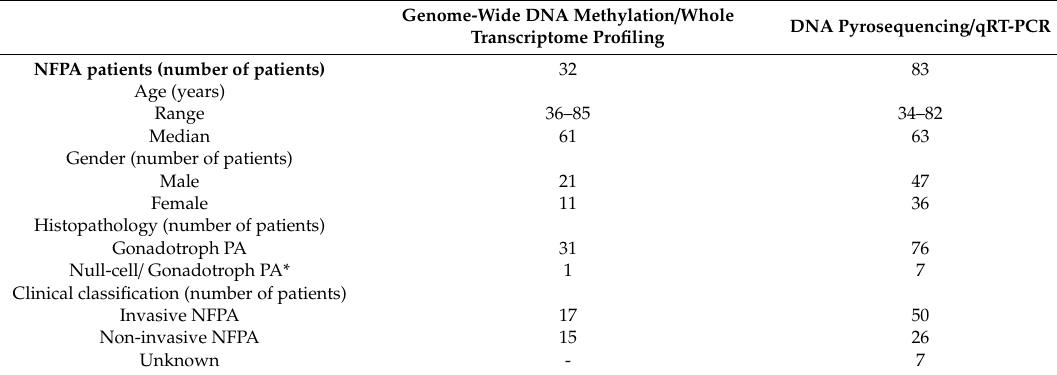
Table 3. Clinical characteristics of pituitary adenoma